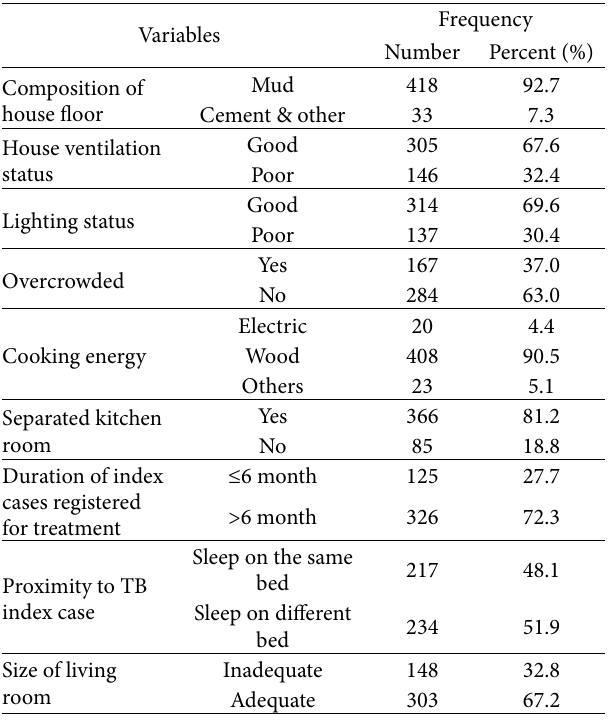
Table 2: Housing condition of adult household contacts of smear positive PTB patients in Haramaya district, Eastern Ethiopia, 2019 ( 푛 = 451 ).